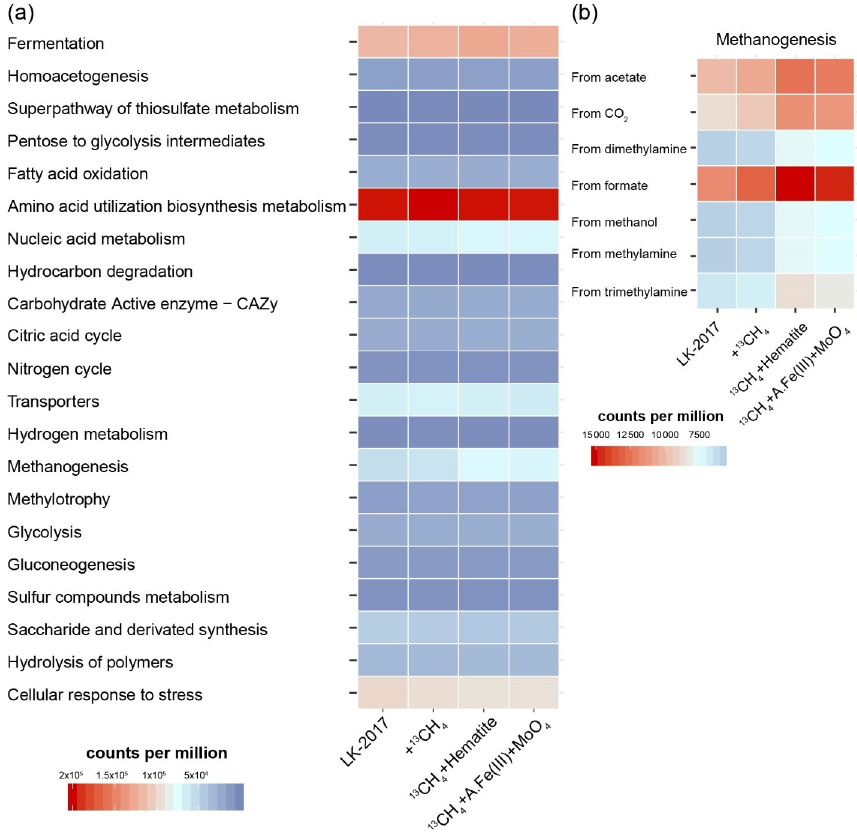
Figure 2. The metabolic potential of microbial communities in Lake Kinneret sediments and slurry incubations. Reads were mapped to metagenomic ORFs to which KEGG functions were assigned. KEGG functions were organized and grouped into FOAM (Functional Ontol- ogy Assignments for Metagenomes) categories. The relative abundance of each FOAM category is presented in counts per million. (a) Gen- eral pathways. (b) Zooming into the pathway of methanogenesis. A.Fe(III) + MoO 4 : amorphous iron and